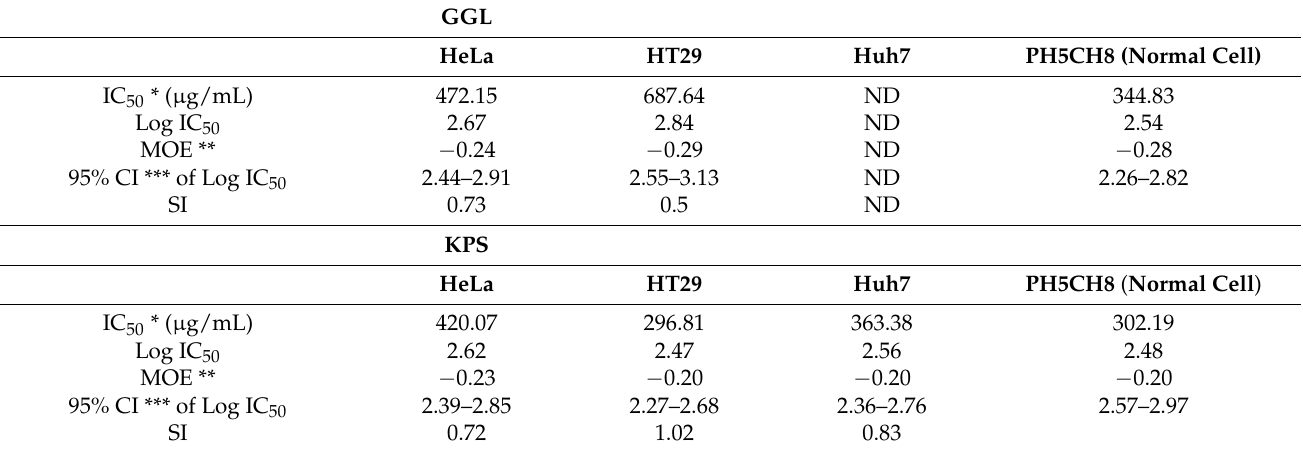
Table 2. GGL and KPS crude extract IC 50 and SI values against tested cell lines.